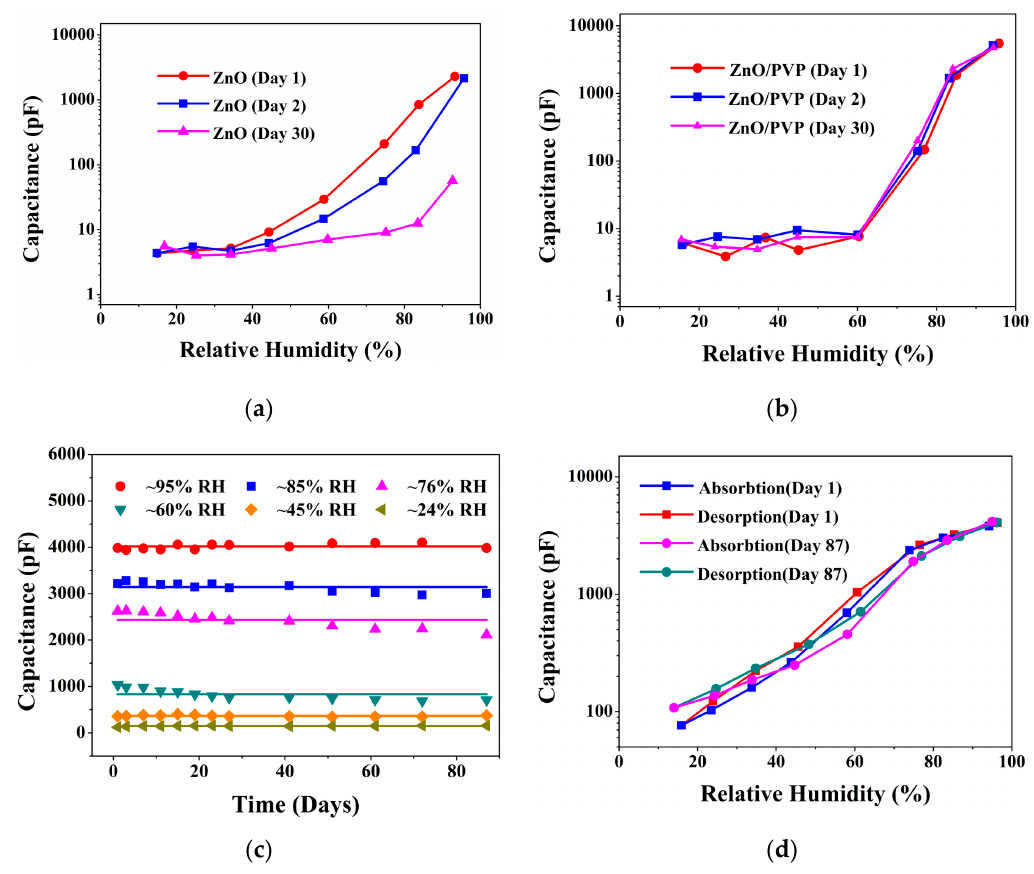
Figure 7. Capacitance vs. RH for ( a ) ZnO and ( b ) ZnO/PVP sensors in one month. ( c ) Stability of the ZnO/PVP-RGO sensor under various RH conditions. ( d ) Capacitance vs. RH for ZnO/PVP-RGO sensor, showing good stability and little hysteresis over 87 days.